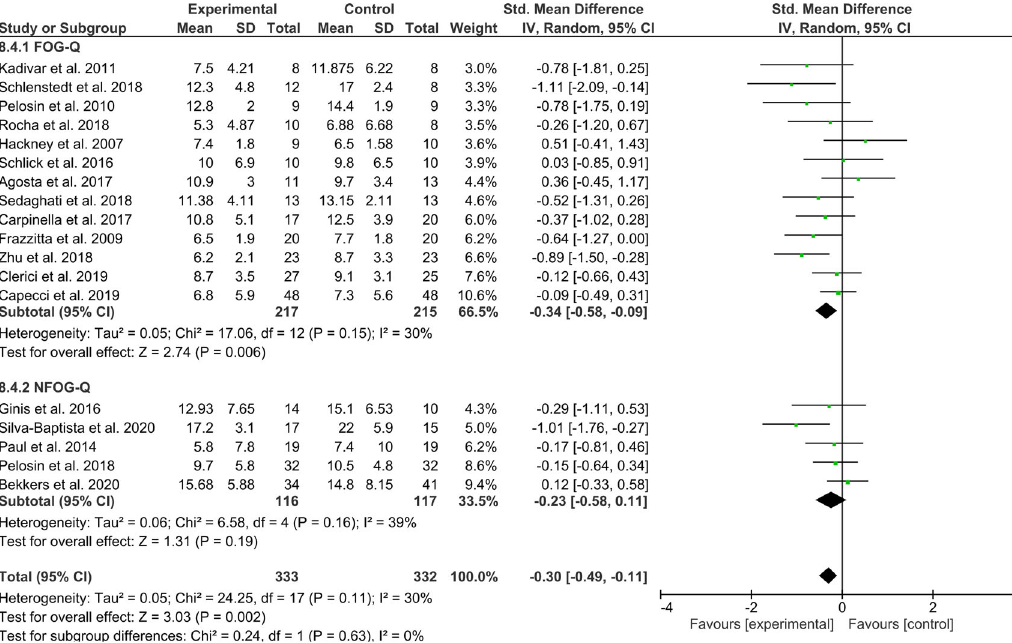
Not all studies included only patients with FOG. As such, a secondary analysis was performed on 14 studies that only enrolled 47.75, p < 0.00001, I 2 = 73%) (Fig. 6). A sensitivity analysis revealed